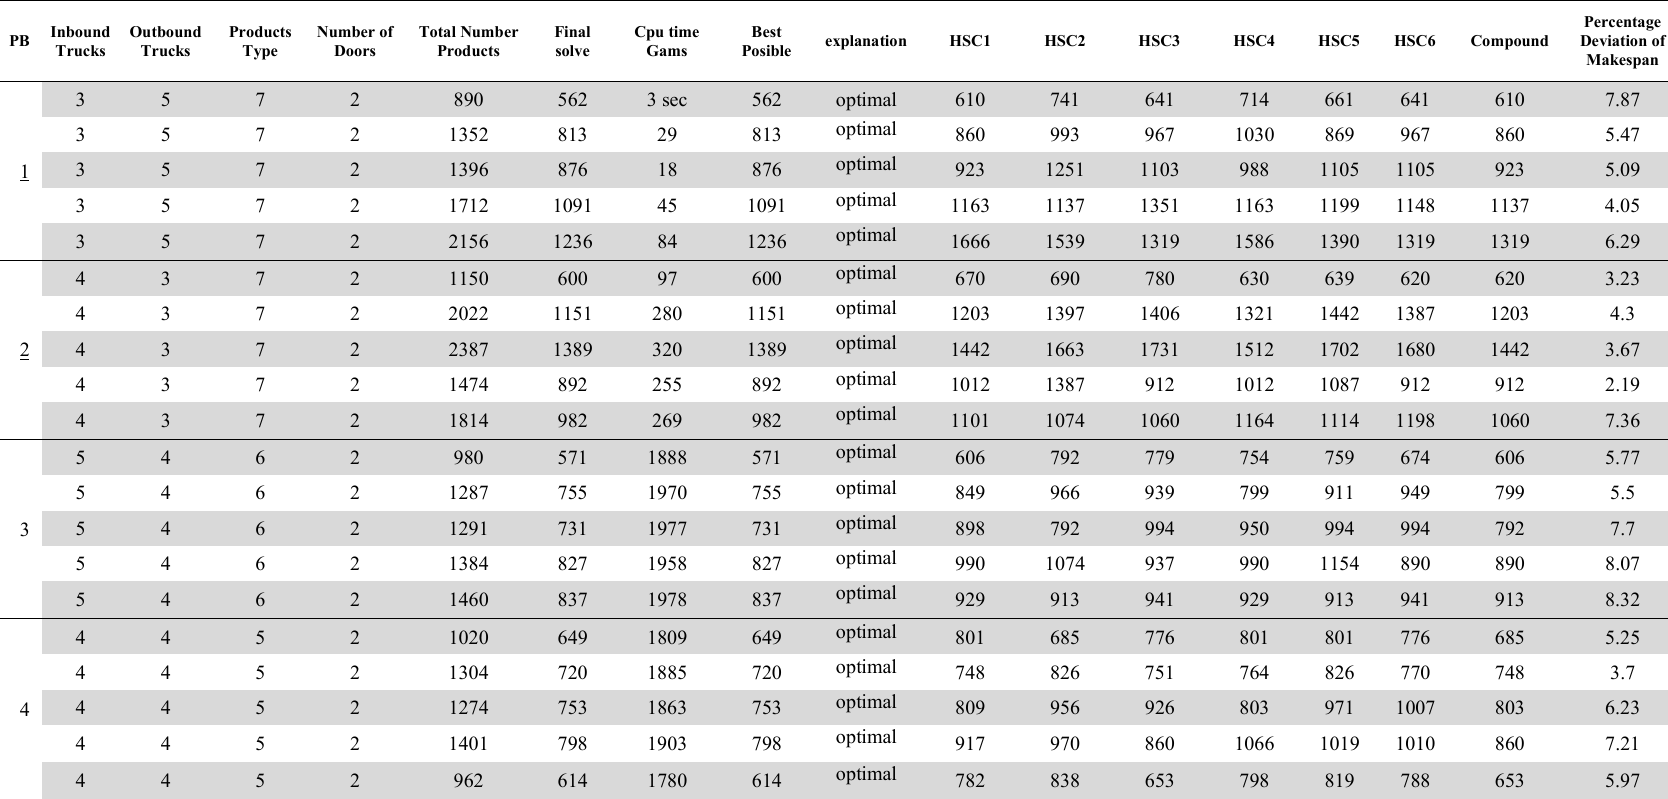
Examples results in small